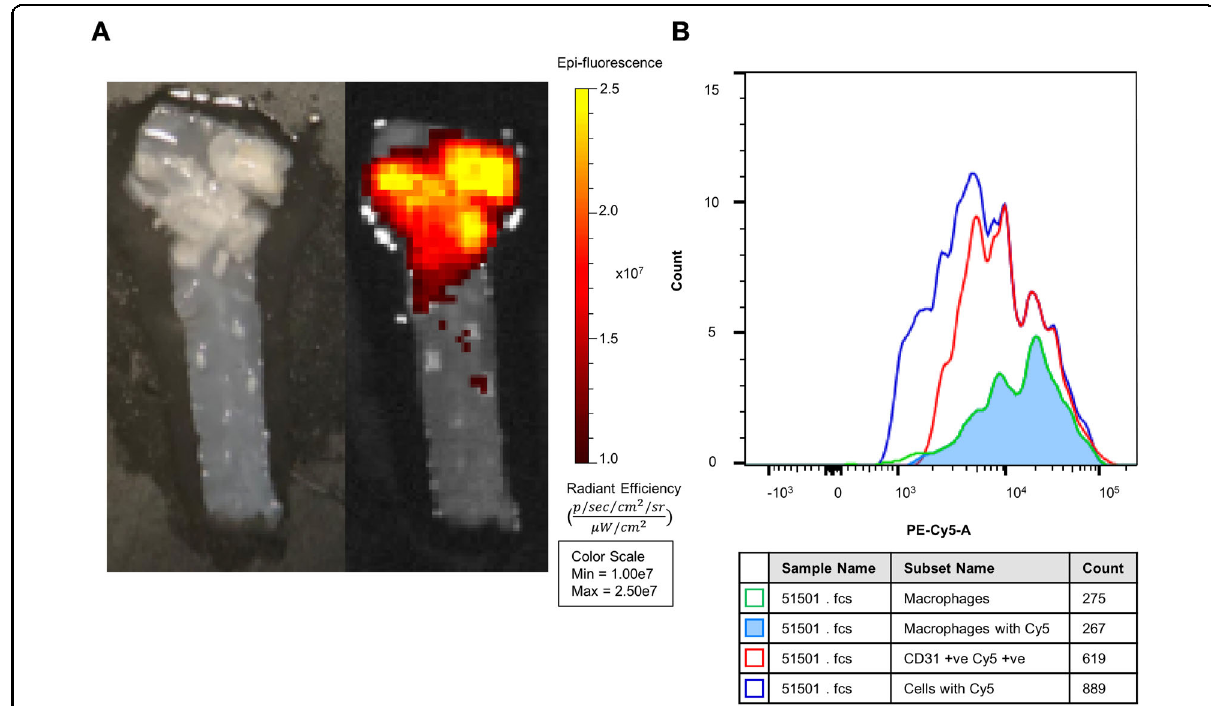
Fig. 8 Localization of AfFtnAA in atheroscelerotic lesion sites. A Optical photograph and ex vivo fl uorescence image obtained from IVIS of the aorta 1 h after mice were injected with Cy5-conjugated AfFtnAA. B Flow cytometry of the aorta samples indicating Cy5-positive cells (blue) and CD31-positive cells (red). The total number of macrophages present and the number of Cy5-positive macrophages are shown in green and as shaded blue areas,